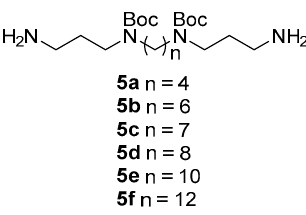
Figure 3. Boc-protected polyamines 5a – f .